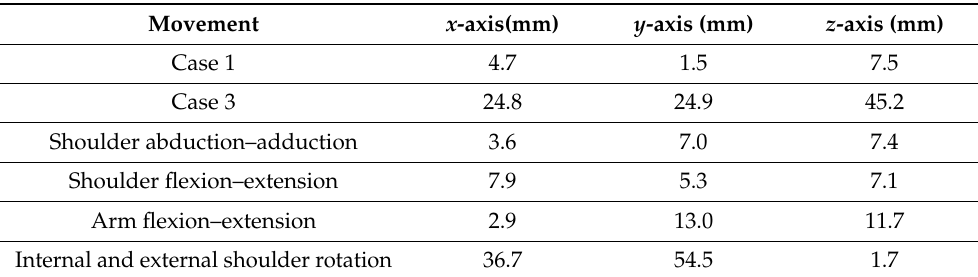
Figure 7. Case 1 -Exclusive series of exercises per joint ( a ) on the x -axis, ( b ) on the y -axis, and ( c ) on the z -axis.